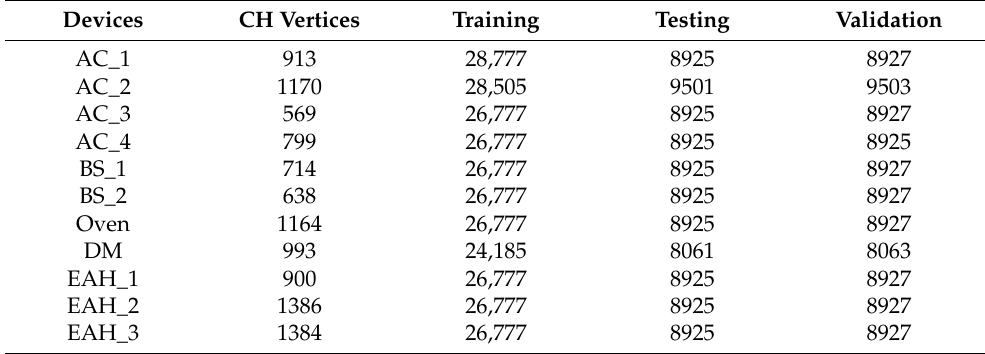
Table 20. Data selection results for classification models.